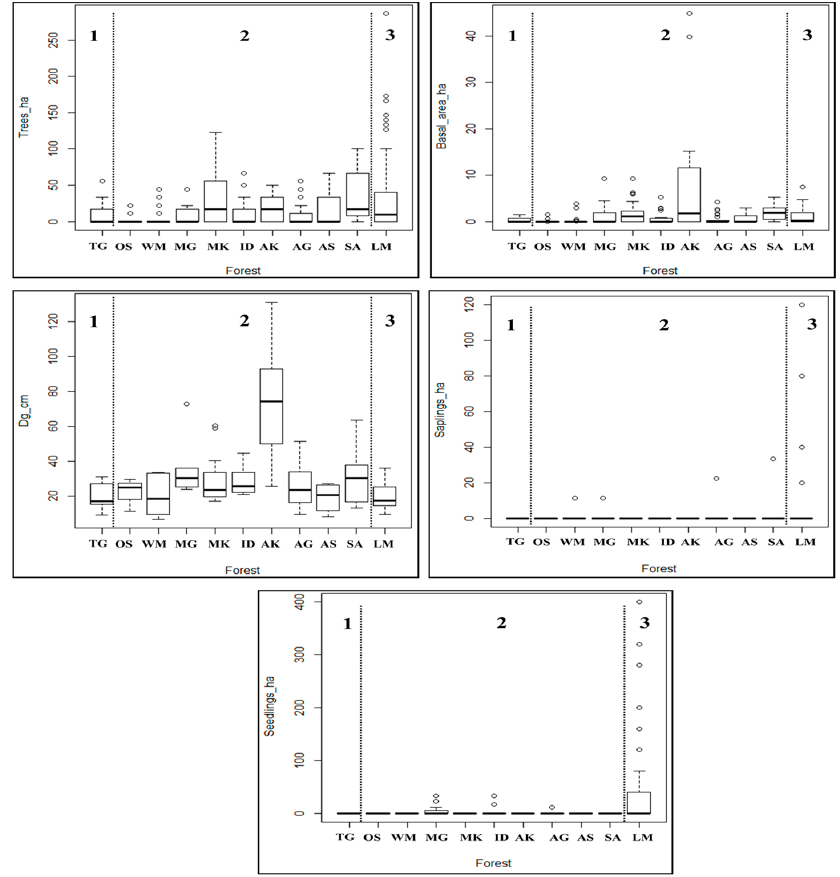
Figure 2. Tree density, basal area, mean diameter (Dg), sapling and seedling density (mean, Standard Deviation, min.–max.) according to forests. TG = Tanougou; OS = Ouémé Supérieur; WM = Wari- Maro; MG = Manigri; MK = Monts Kouffé; ID = Idadjo; AK = Aklamkpa; AG = Agoua; AS = Assanté; SA = Savè; LM = Lama; 1 = semi-arid zone; 2 = sub-humid zone; 3 = humid zone.